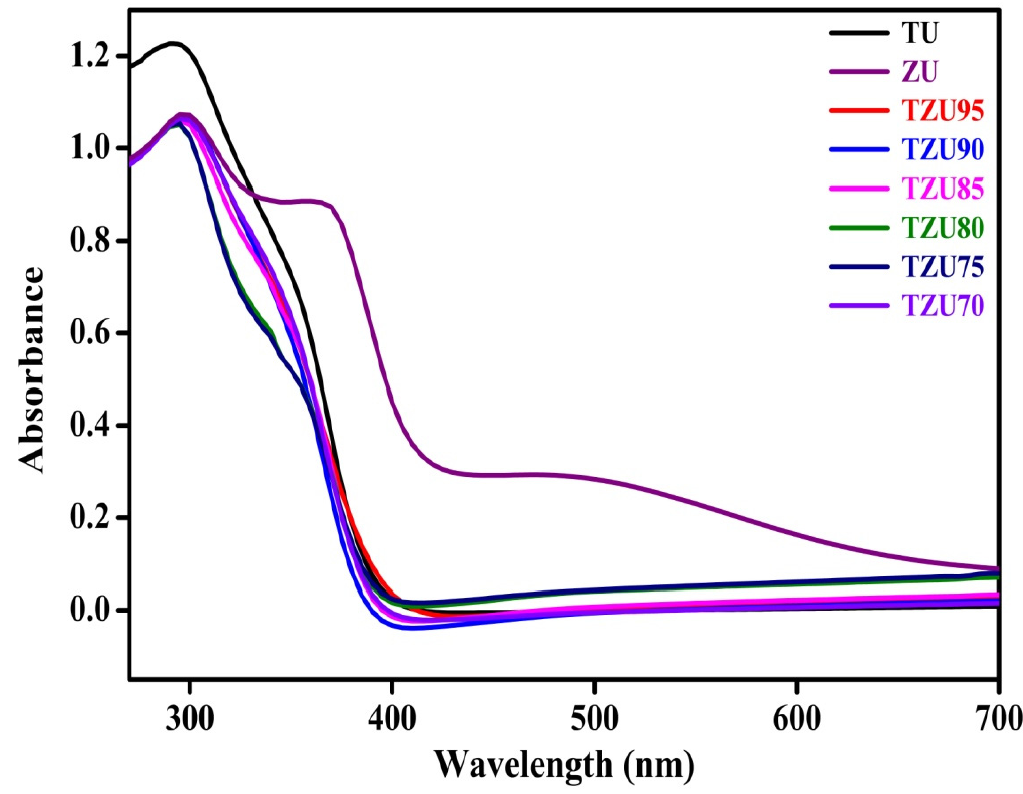
Figure 4. UV–Vis diffuse reflectance spectra of TU, ZU, TZU95, TZU90, TZU85, TZU80, TZU75 and TZU70.